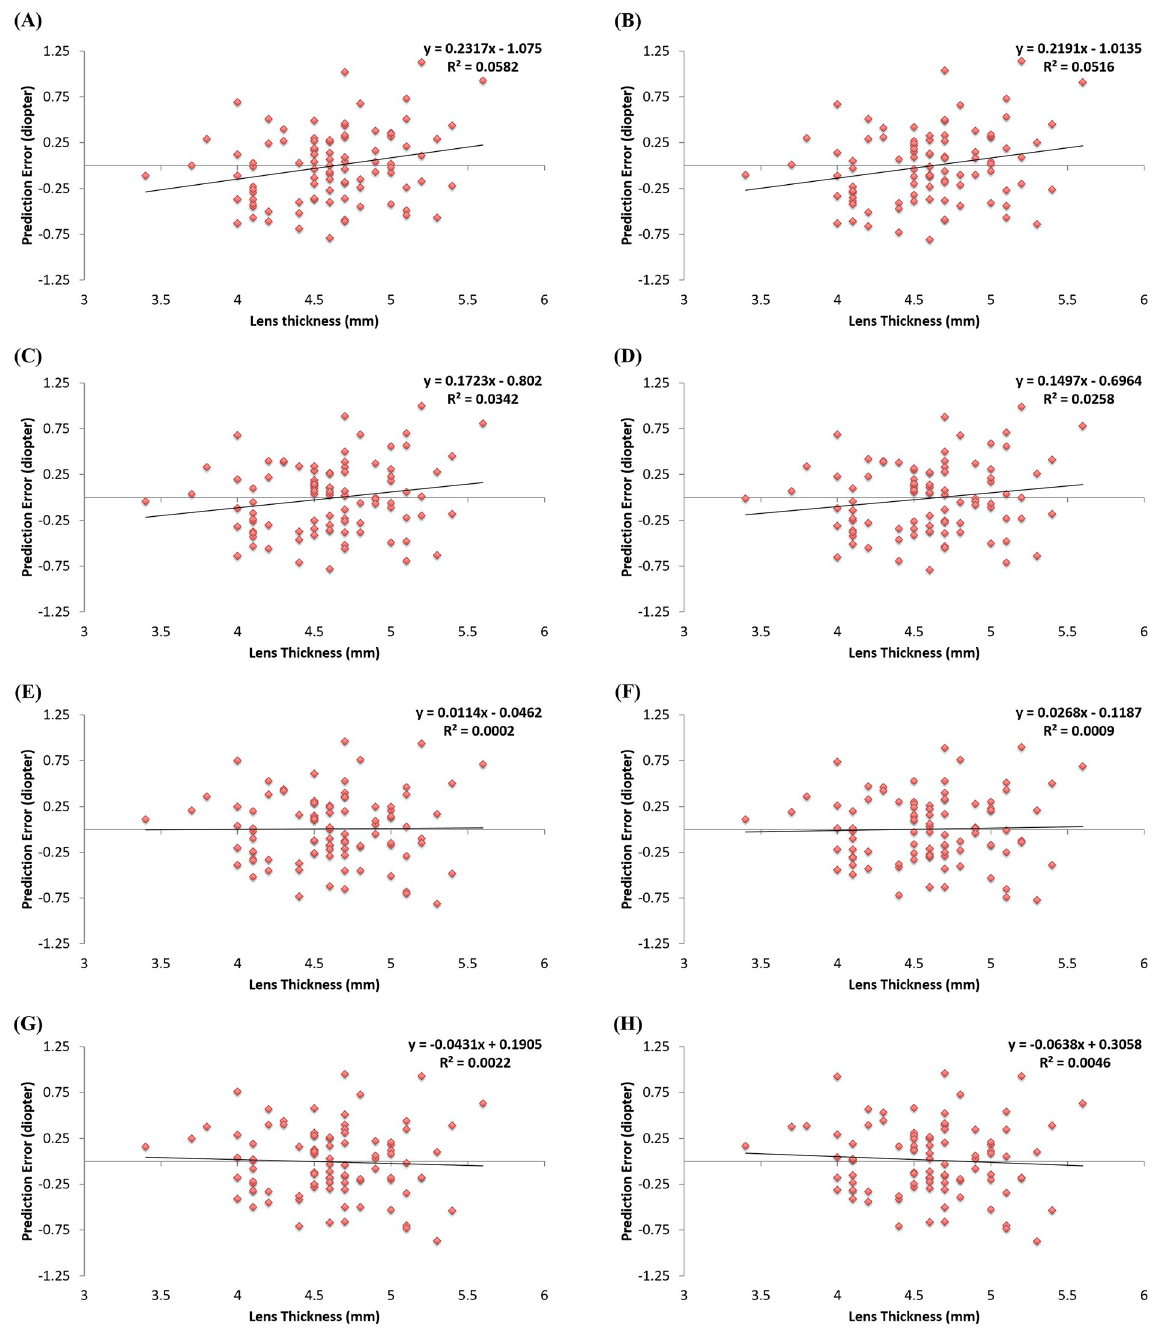
Fig 2. Correlation of preoperative lens thickness with prediction error derived from each intraocular lens formula in training set (n = 92). AL and ACD by PCI (A), AL and ACD by AS 3-D OCT (B), AL and LMP (C), AL, ACD, and aLT (D), AL, ACD, and LT (E), AL, LMP, and pLT (F), AL and ASL (G), AL, ACD, aLT, and pLT (H). AL = axial length; ACD = anterior chamber depth; PCI = partial coherence interferometry; AS 3-D OCT = anterior segment 3-dimensional optical coherence tomography; LMP = lens meridian parameter; aLT = anterior part of lens thickness; LT = lens thickness; pLT = posterior part of lens thickness; ASL = anterior segment length.